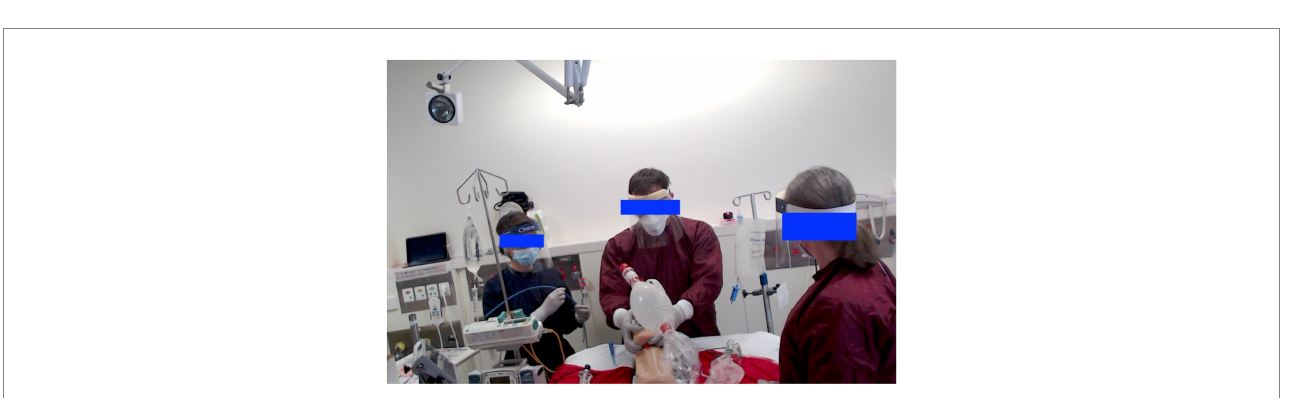
FIGURE 3 Photo of simulated procedure by group 4 (From left to right: N11, D8, D7).